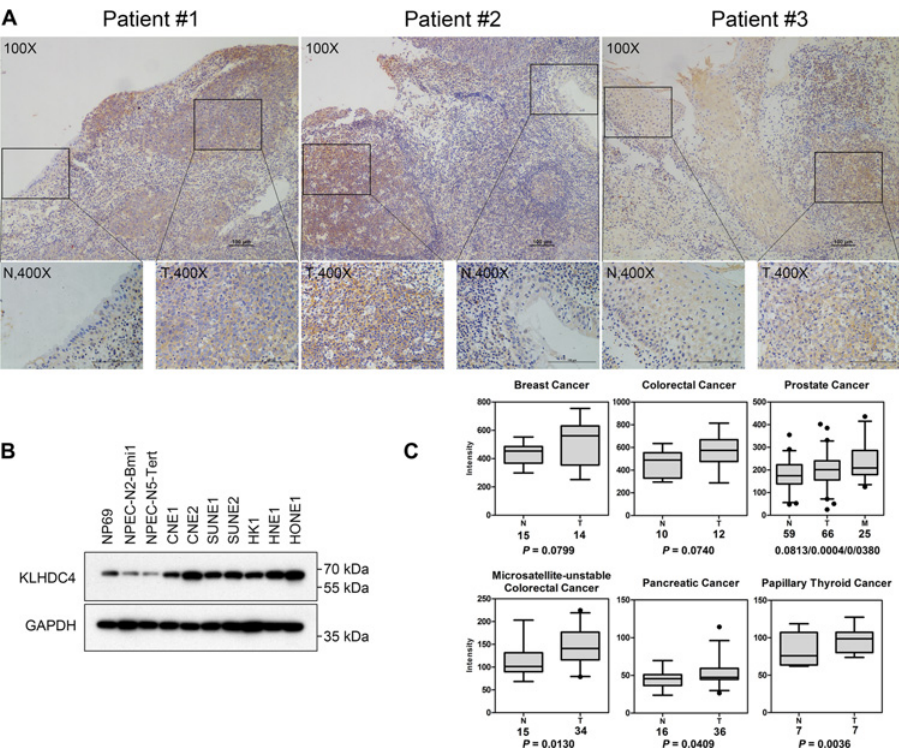
Fig 1. KLHDC4 is overexpressed in NPC tissue and cell lines. (A) Immunohistochemical image of three NPC samples containing both normal adjacent epithelial and tumor tissues stained with an anti-KLHDC4 antibody. N: normal adjacent epithelial tissues; T: tumor tissues. (B) Western blot of KLHDC4 expression in the above cell lines with GAPDH as the loading control. (C) Increased levels of KLHDC4 mRNA are commonly detected in various types of human cancers, as revealed by analyzing Gene Expression Omnibus microarray datasets. The line inside the boxes represents the median value. The box length indicates the interquartile range. The solid round dots have values > 1.5 interquartile ranges but < 3 interquartile ranges from the end of the box. N: normal tissues; T: tumor tissues; M: metastatic tissues. The numbers under the tissue type indicate the total cases of each cancer type. The P values separated with slashes indicate comparisons of normal/tumor, tumor/metastatic and normal/metastatic tissues.